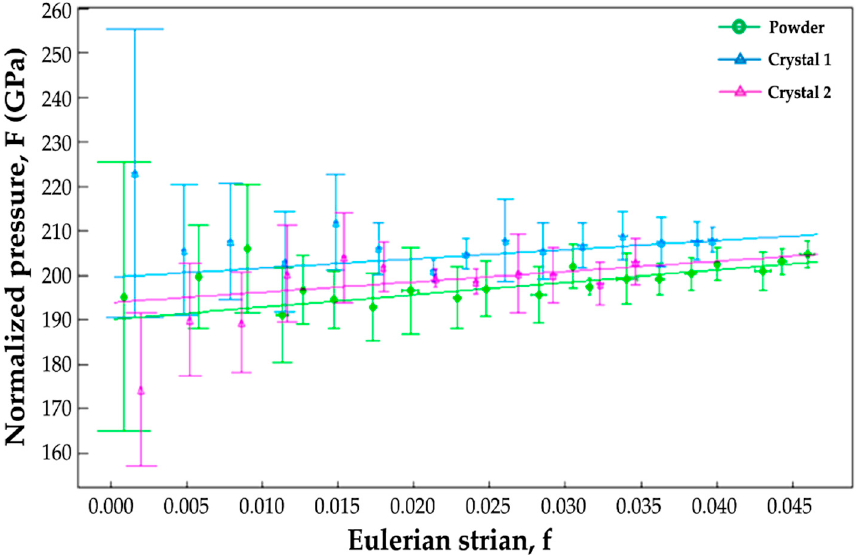
Figure 4. F-f plots for the Ni 3 P compression below the first transition indicate that the second pressure derivative of the bulk modulus (K”) is negligible.